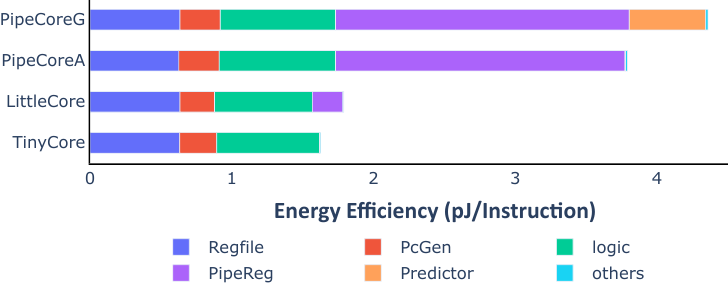
Figure 6. Average energy consumption and distribution of baseline